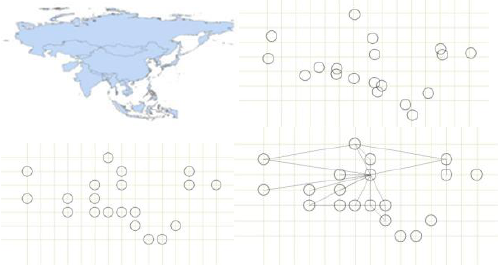
Figure 8. A cartogram algorithm for area features